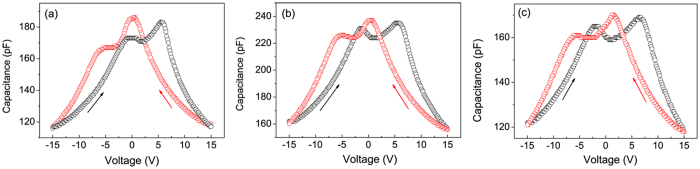
C-V loops of Bi1-δFe0.95Mn0.05O3 films with increasing Bi deficiency contents.(a) δ = 0.005, (b) δ = 0.028, and (c) δ = 0.034.